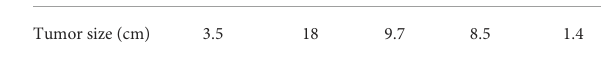
TABLE 2 Tumor size for resection specimens ( N = 32).